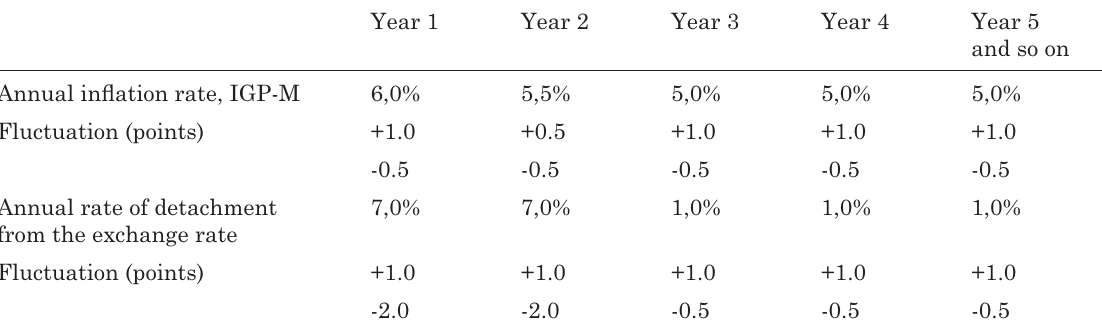
Table 3. Scenario for the operational infl ation and exchange rate